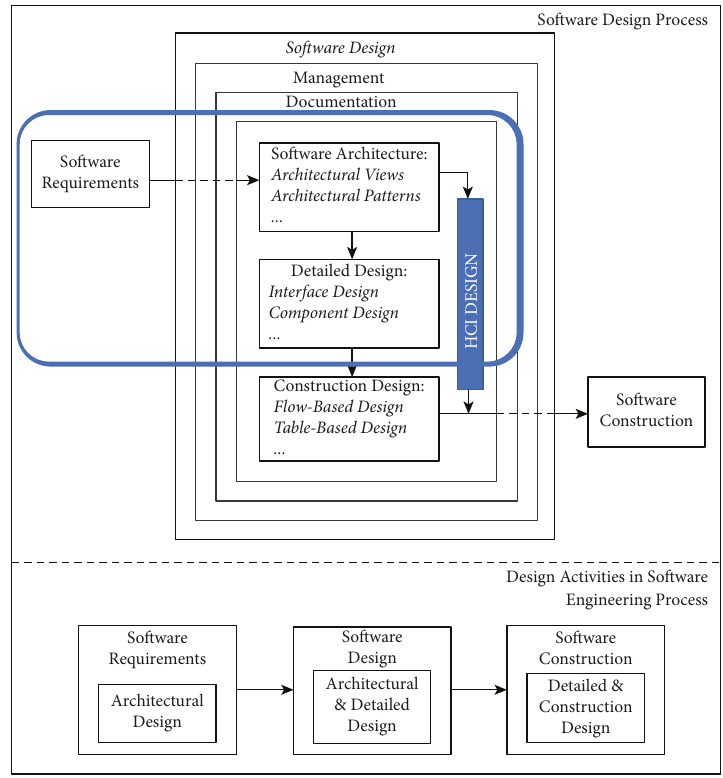
Figure 4: The software design process and design activities during the SWE process